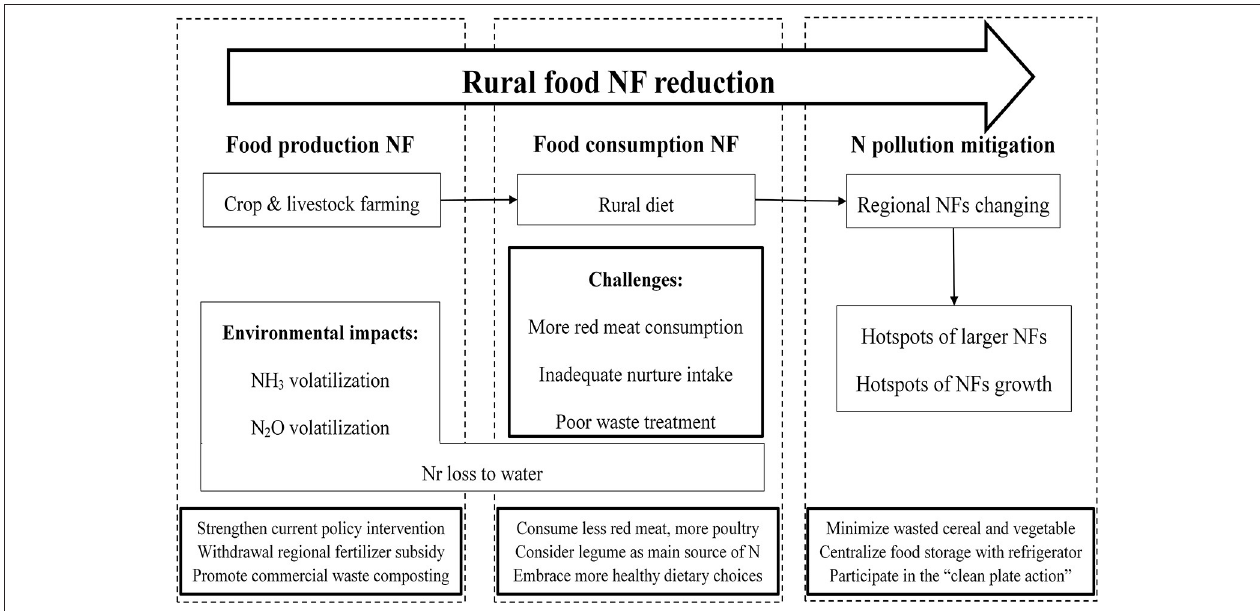
FIGURE 5 | Flowchart showing the mechanism for reducing food NF addressed by relevant strategies.